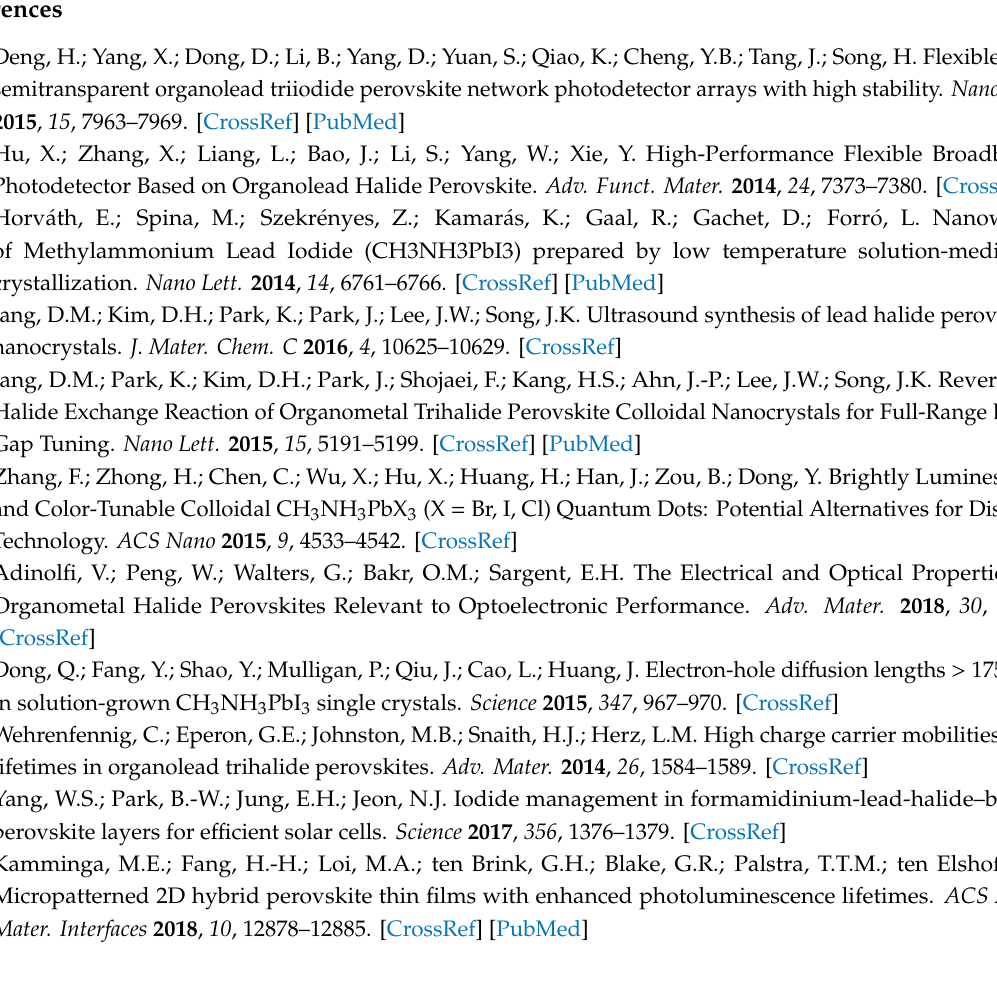
Figure S1. Optical image of the device structure with a channel length and width of 20 and 1000 µ m, respectively; Figure S2. Cross-sectional SEM image of the device structure showing thickness of composite film; Figure S3. HRTEM images of typical (a) CDs, (b) perovskite, and (c), (d) CsPbBr3 / CD composite showing the hexagonal honeycomb structure of the CDs; Figure S4. Top-surface SEM image of the CsPbBr 3 and the CsPbBr 3 / CD films in (a) and (b), respectively; Figure S5. 2DAFM image of the CsPbBr3 film along with line profile of red line in (a) and (b), 3D AFM image of the CsPbBr 3 film (c); Figure S6. 2DAFM image of the CsPbBr 3 / CD film along with line profile of green line in (a) and red line in (b), 3D AFM image of the CsPbBr 3 / CD film (c); Figure S7. 3D AFM image of the CsPbBr3 / CD film showing defects on the surface of the film; Figure S8. Optical image of device channel after depositing the CsPbBr3 /